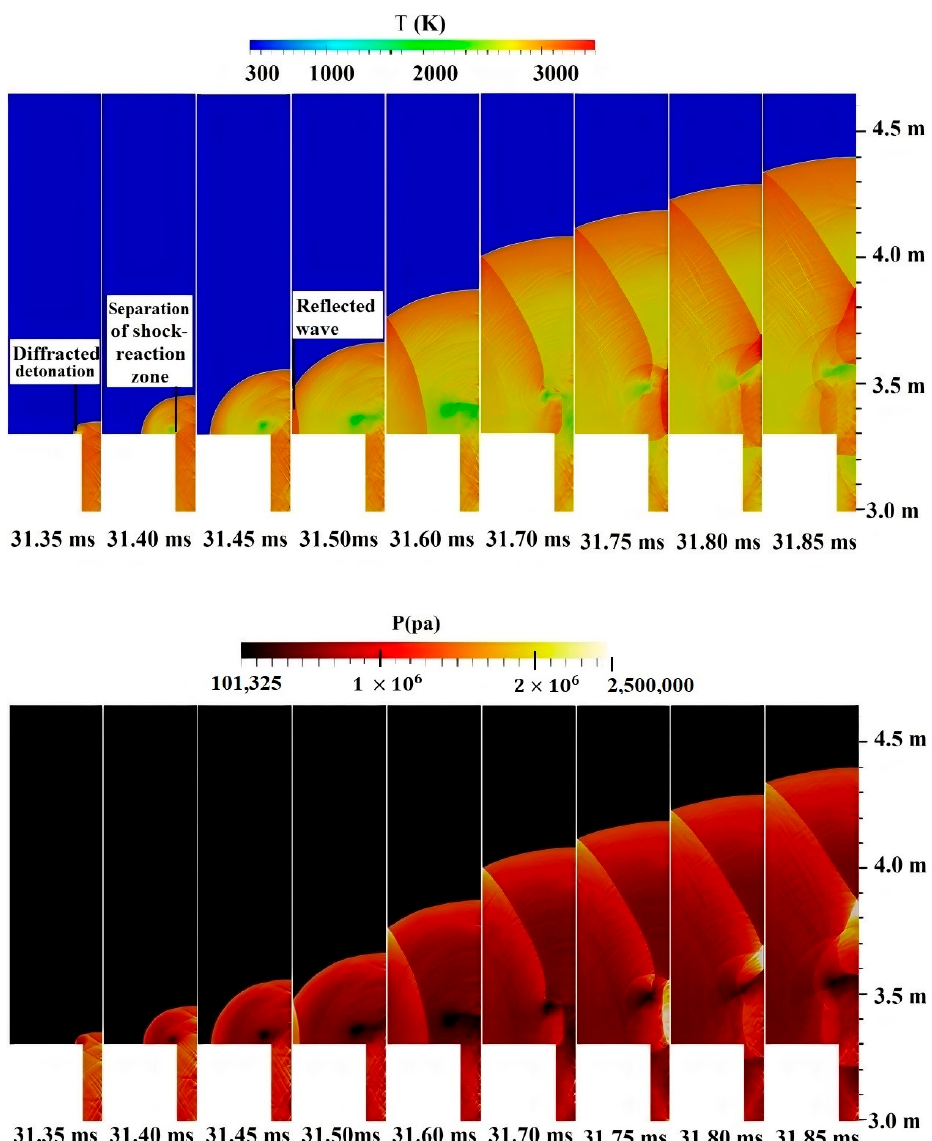
Figure 12. The temperature and pressure contours for the propagation of the flame in the H 2 –air mixture with 30% hydrogen concentration.